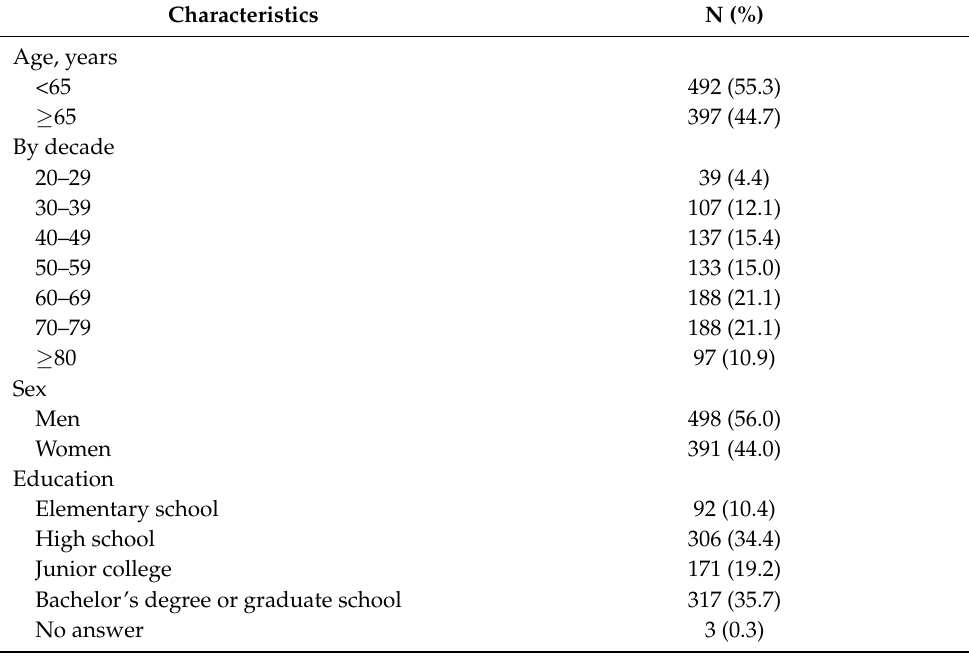
Table 1. Characteristics of the respondents, N = 889.